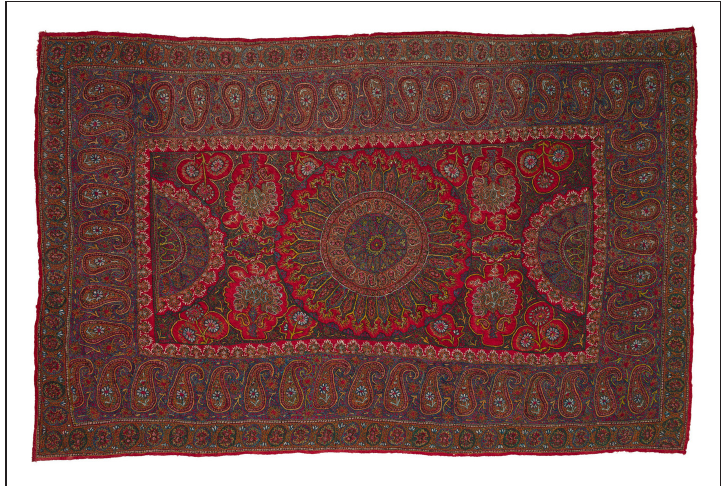
Fig. 10 : Embroidered table cover, wool and silk, Iran (Kerman), nineteenth century. T12, given by Miss E. G. Tanner in 1927. © Holburne Museum, Bath. Photo: